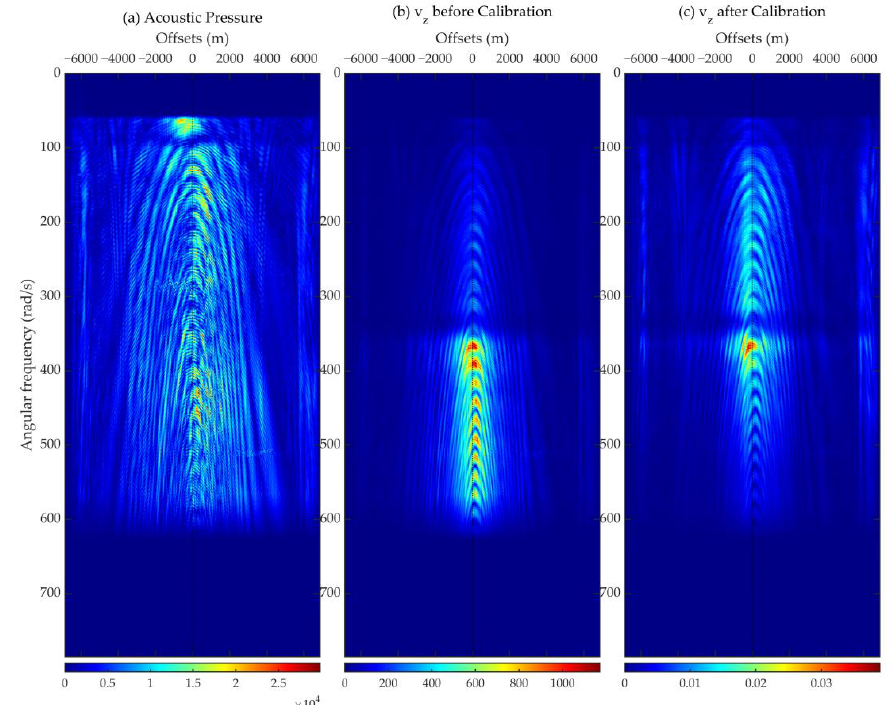
Remote Sens. 2022 , 14 , x FOR PEER REVIEW Figure 6. Comparison of the ( a ) acoustic pressure component, and vertical particle velocity component ( b ) before and ( c ) after calibration, in the ω - x domain.